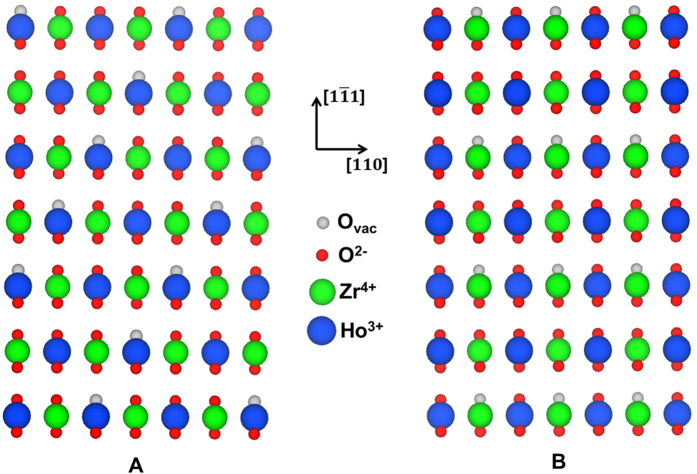
Projections of the lowest (A) and highest (B) energy A2B2O7-fluorite configurations for Ho2Zr2O7. Projections are shown along the 〈211〉 direction. For clarity, the ions are shown in their unrelaxed fluorite positions, and oxygen vacancies (denoted as Ovac) are represented by gray circles.